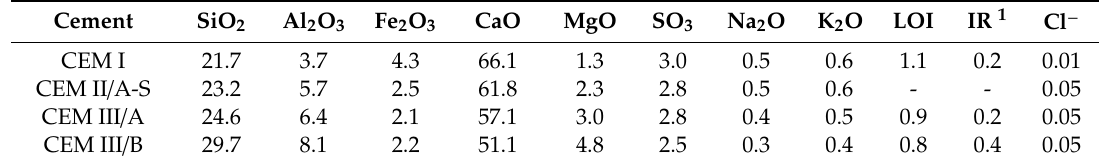
Table 1. Chemical compositions of the cements.